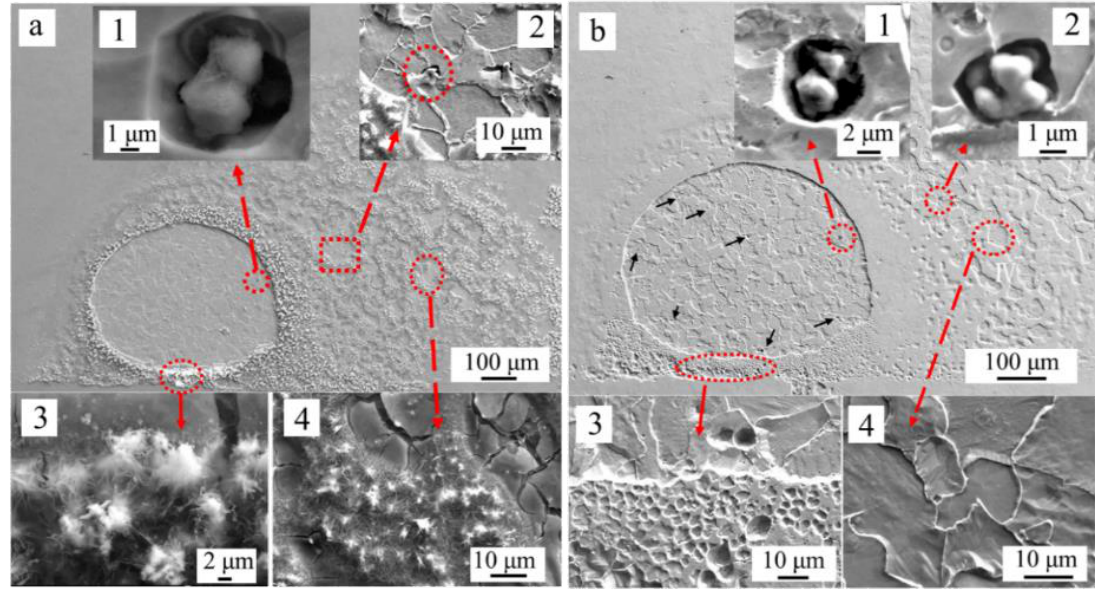
Figure 10. ( a ) SEM image of the corrosion spot before removing the corrosion product, ( b ) SEM image of the corrosion spot after removing the corrosion product.